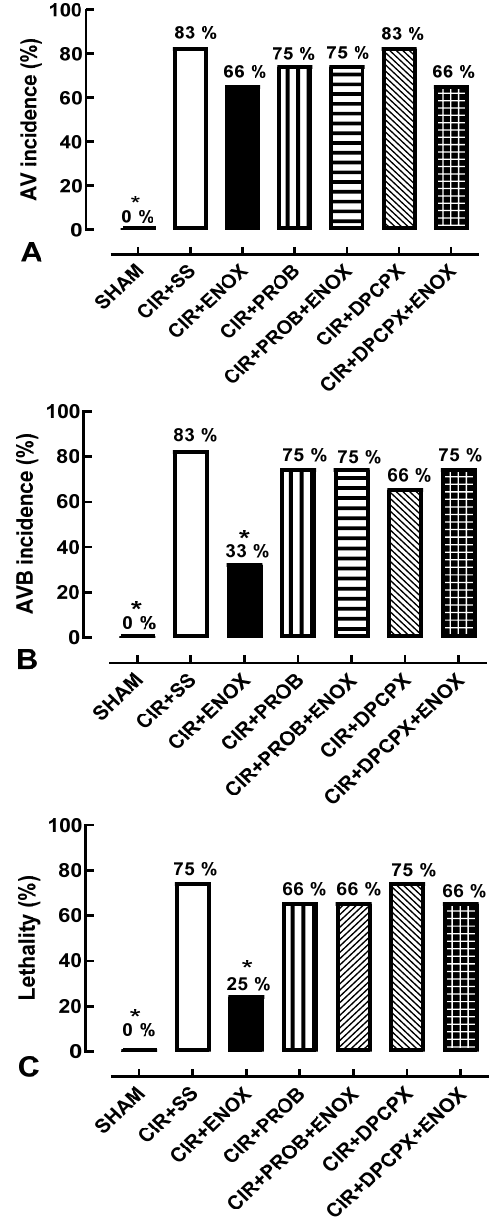
Figure 2. Incidence of ( A ) ventricular arrhythmias (VA); ( B ) atrioventricular block (AVB) and ( C ) lethality (LET) in the SHAM, CIR + SS, CIR + ENOX, CIR + PROB, CIR + PROB + ENOX, and CIR + DPCPX + ENOX groups. The results are expressed as percentage frequencies and compared with Fisher ’ s exact test (* p < 0.05). VA, AVB, and LET were not observed in the SHAM group. ENOX did not reduce the incidence of VA when compared with the control CIR + SS group but did significantly reduce AVB and LET incidence. Disruption of the extracellular cAMP-ADO pathway with either PROB or DPCPX abolished the cardioprotective effect of ENOX on AVB and LET. Treatment with either PROB or DPCPX alone had no effect on mortality. CIR + SS = cardiac ischemia and reperfusion group treated with saline solution; CIR + ENOX = cardiac ischemia and reperfusion group treated with enoxaparin; CIR + PROB = cardiac ischemia and reperfusion group treated with probenecid 5 min before CIR; CIR + PROB + ENOX = cardiac ischemia and reperfusion group treated with pro- benecid 5 min before treatment with enoxaparin, administered immediately before CIR; CIR + DPCPX + ENOX = cardiac ischemia and reperfusion group treated with DPCPX 5 min before treat- ment with enoxaparin, administered immediately before CIR. Pretreatment with drugs DPCPX and PROB abolished the effects produced by treat- ment with ENOX. Figure 2B shows that AVB incidence was similar in the CIR + ENOX + PROB (75%) and CIR + ENOX + DPCPX (75%) groups compared with the CIR + PROB (75%) and CIR + DPCPX (66%) groups, respectively. Figure 2C shows that LET incidence